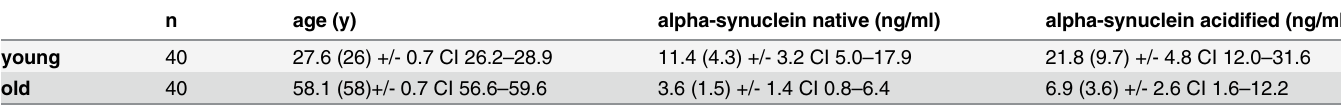
Table 1. Alpha-synuclein concentration in native and acidified plasma in a younger and older group of healthy males.